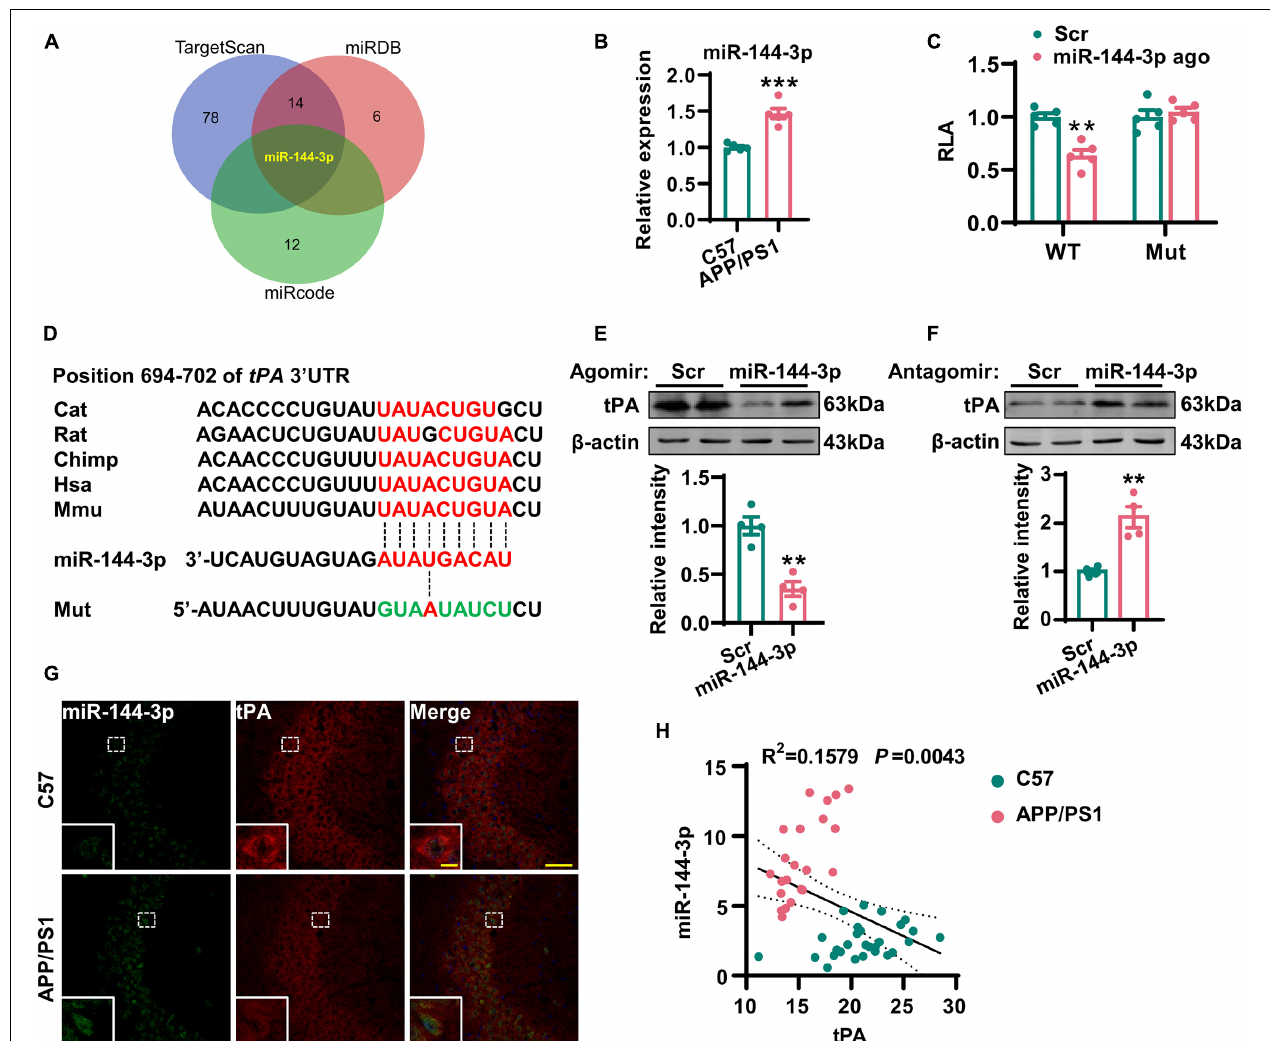
FIGURE 4 | Increased expression of miR-144-3p led to the translational repression of tPA. (A) The miRNAs potentially regulating the tPA translation were shown in a Venn diagram by three different online tools as indicated. (B) The expression profiles of this candidate miRNA in the hippocampi of 12-months-old APP/PS1 mice and C57 mice were evaluated by Q-PCR. Unpaired Student’s t -test was used, n = 5 mice for each group, *** p < 0.001. (C) The wild-type (WT) or mutant (Mut) 3 (cid:48) -UTR of tPA in psiCHECK-2 vector was co-transfected into N2a cells with miR-144-3p agomir or scrambled control (Scr). The luciferase activity was determined at 48 h after the transfection. Multiple t -test adjusted with the Holm–Šidák method, n = 5 for each group, ** p < 0.01. (D) Diagram to display the conserved binding site in tPA 3 (cid:48) -UTR to the miR-144-3p. The mutant sequence in 3 (cid:48) -UTR of tPA for luciferase analysis was provided at the bottom. (E) N2a cells were transfected with miR-144-3p agomir or Scr. The cell lysates were collected, and the protein levels of tPA were then detected 48 h later by western blotting. The quantitative analysis was shown in the lower panel. Unpaired Student’s t -test was used, n = 4 for each group, ** p < 0.01. (F) N2a cells were transfected with miR-144-3p antagomir (miR-144 anta) or Scr. The protein levels of tPA were detected 48 h later by western blotting. The quantitative analysis was shown in the lower panel. Unpaired Student’s t -test, n = 4 for each group, ** p < 0.01. (G) The staining of fluorescence in situ by using the probe of miR-144-3p (green) and immunofluorescence of anti-tPA (red) antibody was performed in the hippocampi of APP/PS1 mice and C57 mice at 12 months. Bar = 50 µ m. The representative image of an amplified neuron was shown in the southwest corner. Bar = 5 µ m. (H) The correlation analysis between the intensities of miR-144-3p and tPA in (G) . n = 22 or 28 from the APP/PS1 mice or C57